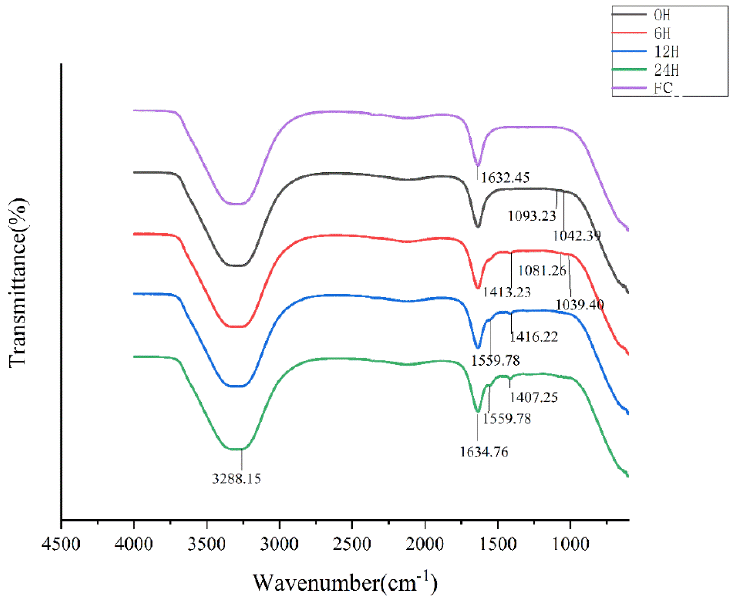
Figure 3. FT-IR spectra of FSP and its fermentation fractions (FC: Fermentation Figure 3. FT ‐ IR spectra of FSP and its fermentation fractions (FC: Fermentation culture).